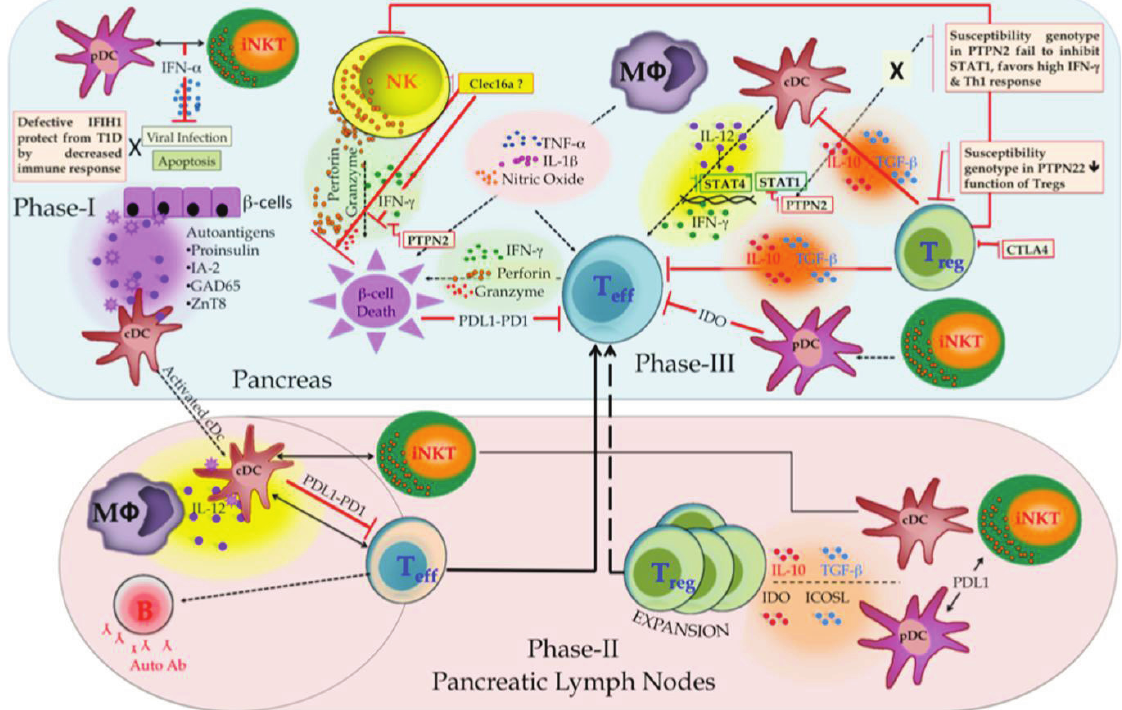
Figure 3. Pathogenesis model of T1D involves complex interactions between innate and adaptive immune cell